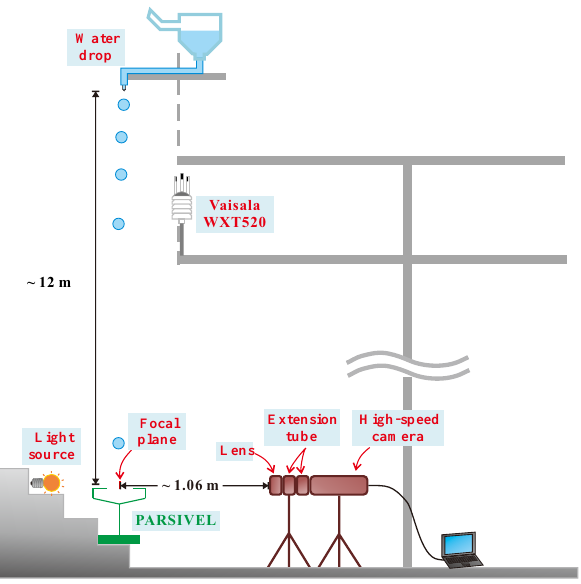
Figure 1. Instruments and experimental settings adopted for the Fig. 1. Instruments and experimental settings adopted for the present present study (see text for details). study (see text for details).